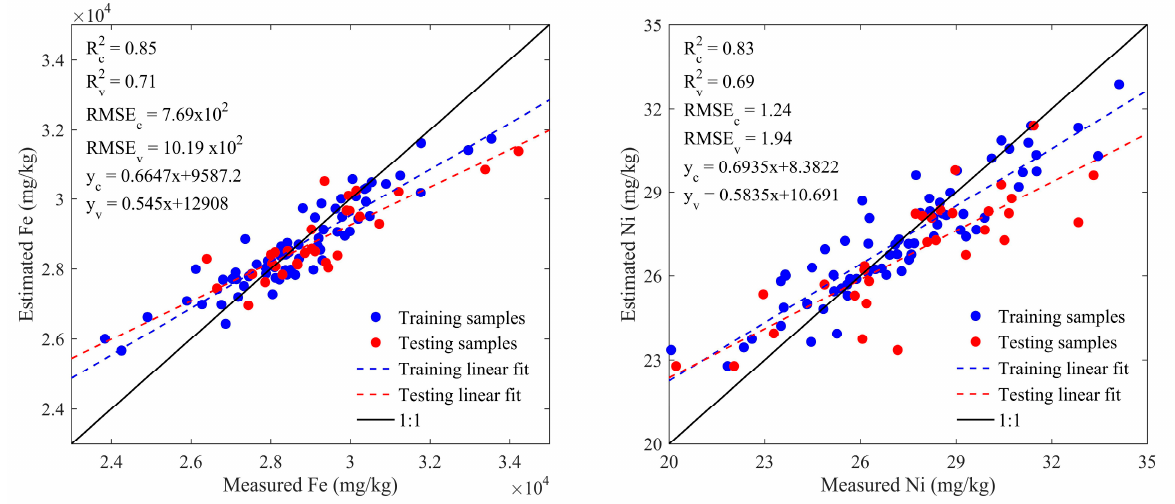
Figure 8. The scatterplots for Fe and Ni content estimation under LPS conditions based on the RF